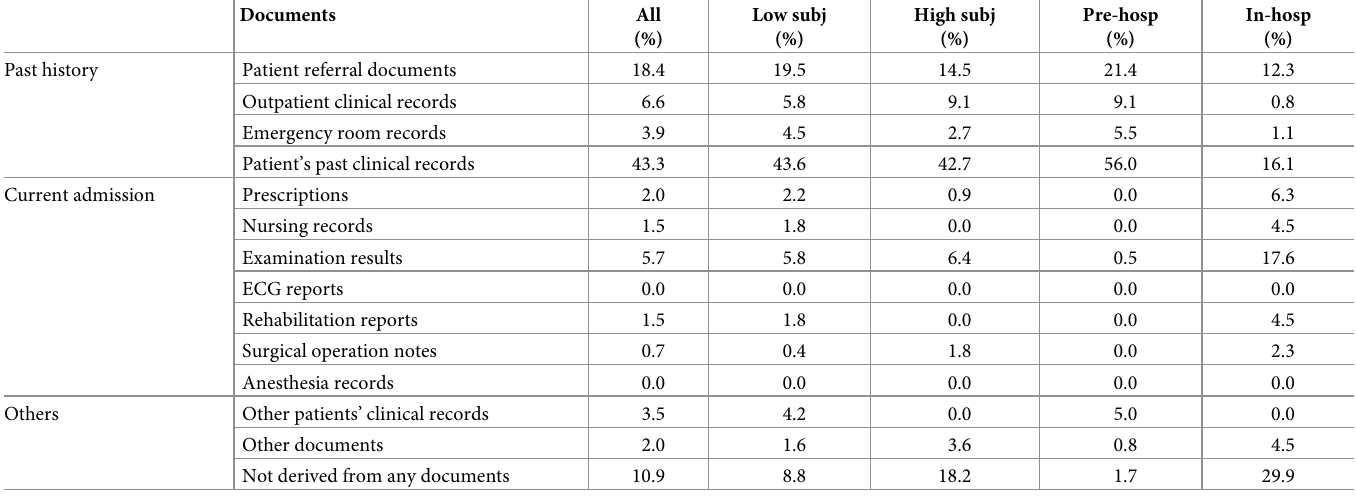
Table 7. List of source documents that the annotators selected for each piece of information labeled as not sourced from inpatient records . The numbers indicate the percentage of external documents in each section. Low subj , High subj , Pre-hosp , and In-hosp in the table show the distribution of assumed external sources for segments classified as unsourced. Because it has a multi-label structure, each segment may have multiple source labels, and the percentile is calculated against the total number of assigned